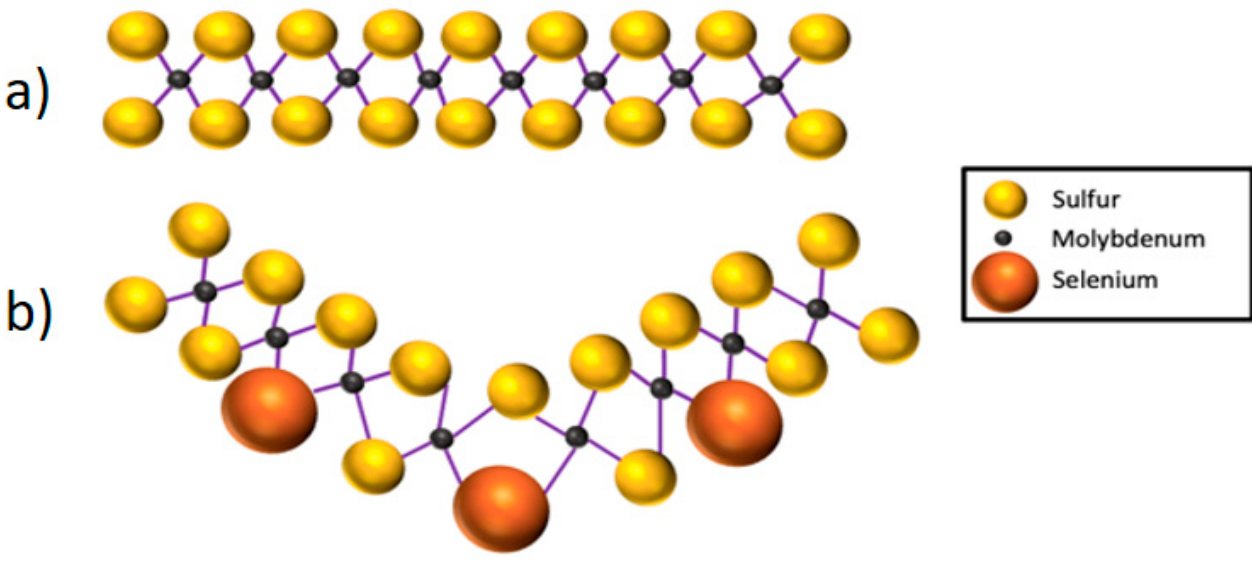
Figure 13. ( a ) MoS 2 layer and ( b ) substitution of the sulfur atom by selenide leads to a curved structure (after [128]). This increases interlayer distance and reduces friction.